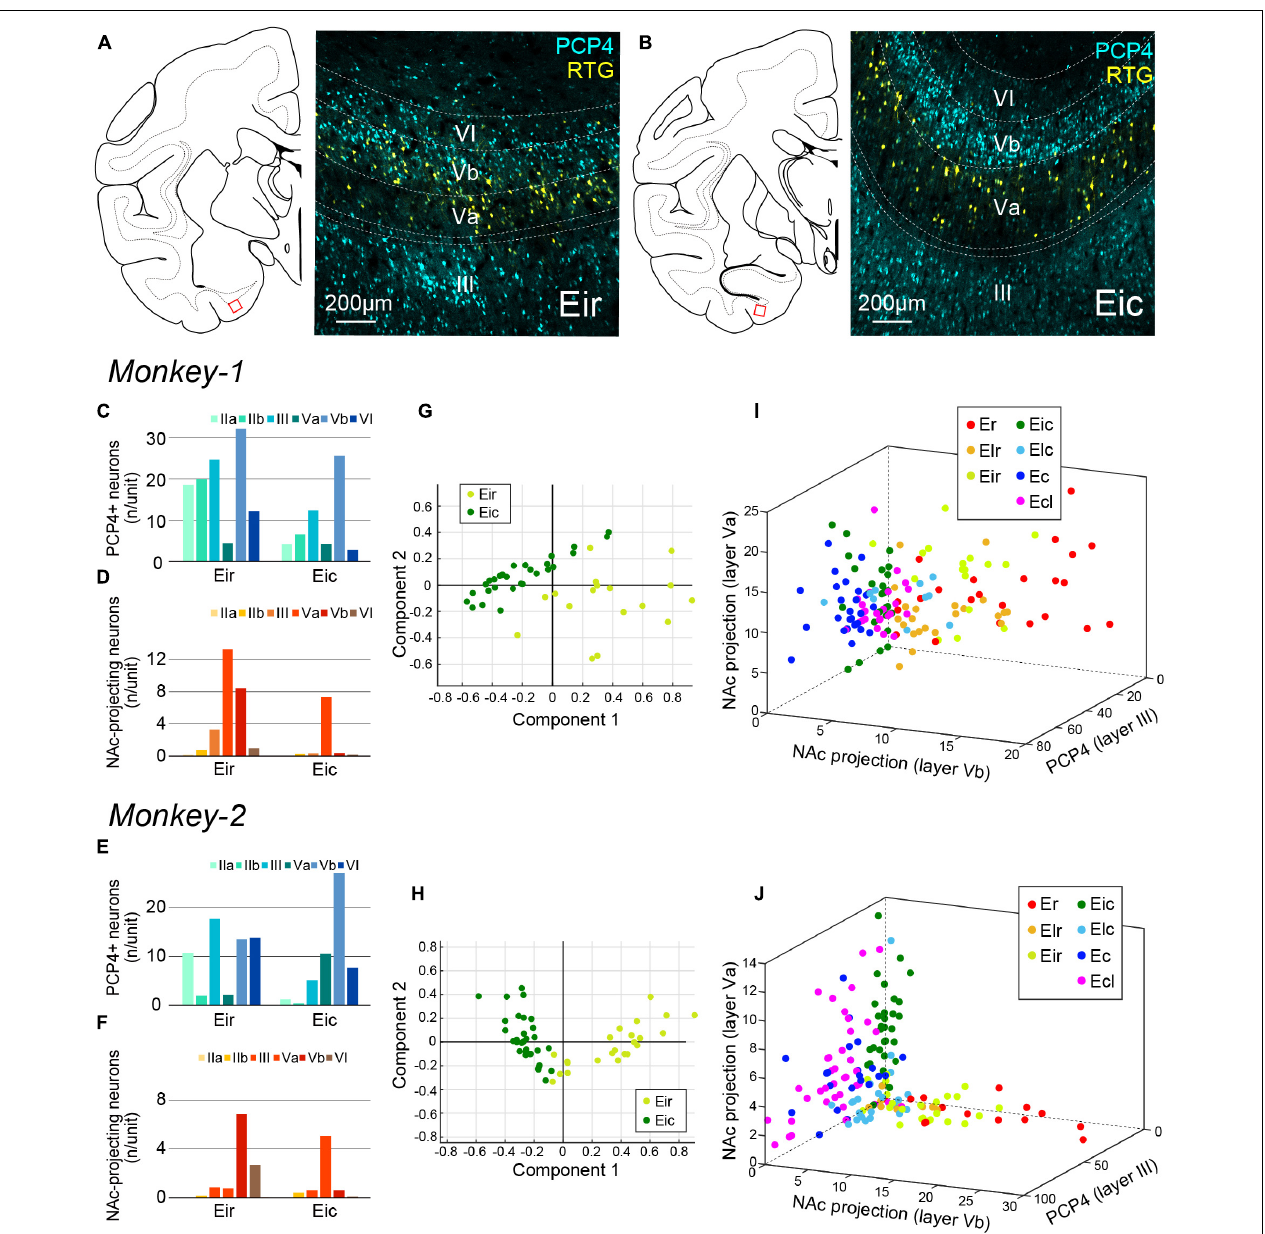
FIGURE 6 | Parcellation of Ei based on PCP4 + and NAc-projecting neurons. (A,B) Fluorescent micrographs of NAc-projecting retrogradely labeled neurons (RTG + ; yellow) and PCP4 + neurons (cyan) in Eir (A) and Eic (B) . For both images, the position is indicated as the red squared area in the schematic line drawing of the coronal section to the left. (C–F) A diagram showing the number/unit of either PCP4 + neurons (C,E) or NAc-projecting neurons (D,F) in Eir and Eic across layers in Monkey-1 (C,D) and Monkey-2 (E,F) . (G,H) Principal component analysis for Monkey-1 (G) and Monkey-2 (H) based on the parameters shown in (C–F) . (I,J) Separation of EC subdivisions using number/unit of NAc-projecting neurons in layer Va, and layer Vb, and the number of PCP4 + neurons in layer III as distinction criteria, in Monkey-1 (I) and Monkey-2 (J)